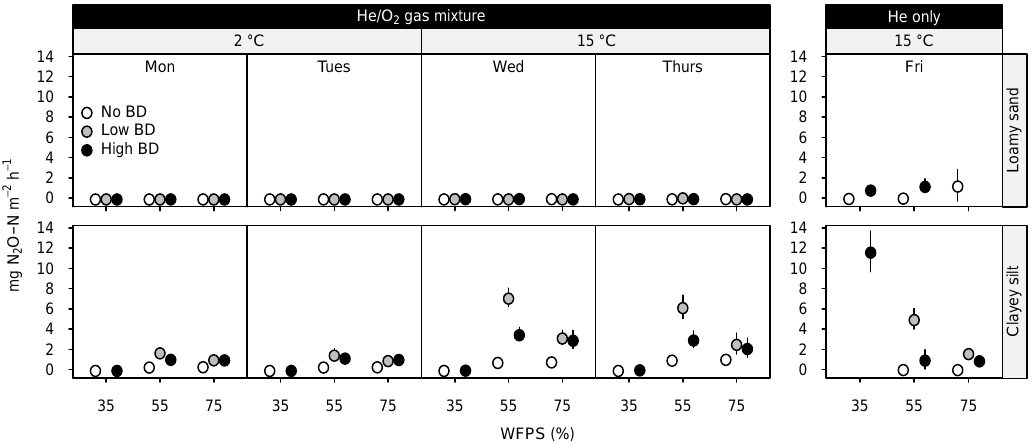
Figure 3. Mean N 2 O fluxes (mgNm − 2 h − 1 ) from loamy sand and clayey silt incubated under different water-filled pore spaces (WFPSs, %) with different amounts of digestate (0mL per sample ring: no BD, 17.6mL: low BD and 35.2mL: high BD). The first to the fourth days